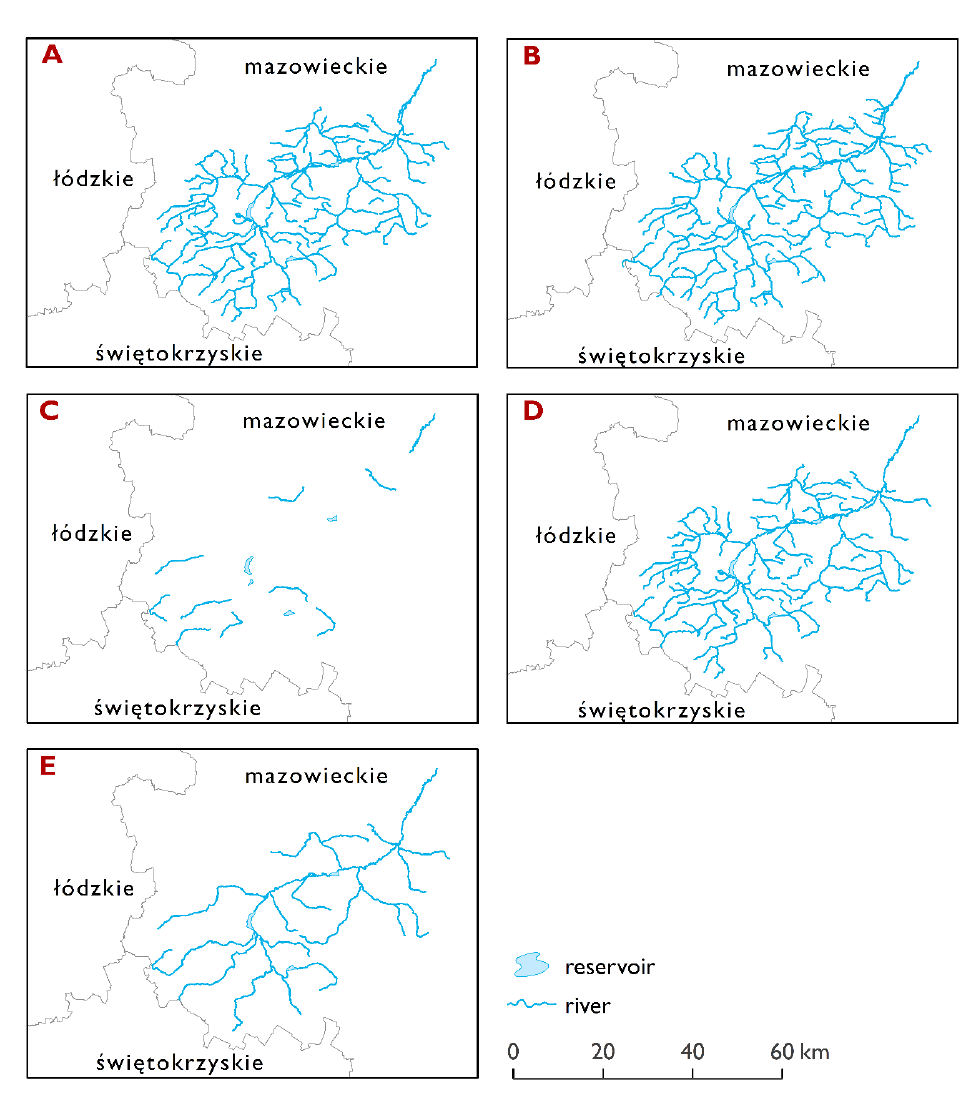
Fig. 6. The results of the generalization of the Radomka basin. A – source data, b – vectorized data from the reference atlas map, C – selection according to the regulation, D – selection according to the regulation using the idMPHP index, E – selection according to the regulation with the use of priority watercourses. Own elaboration